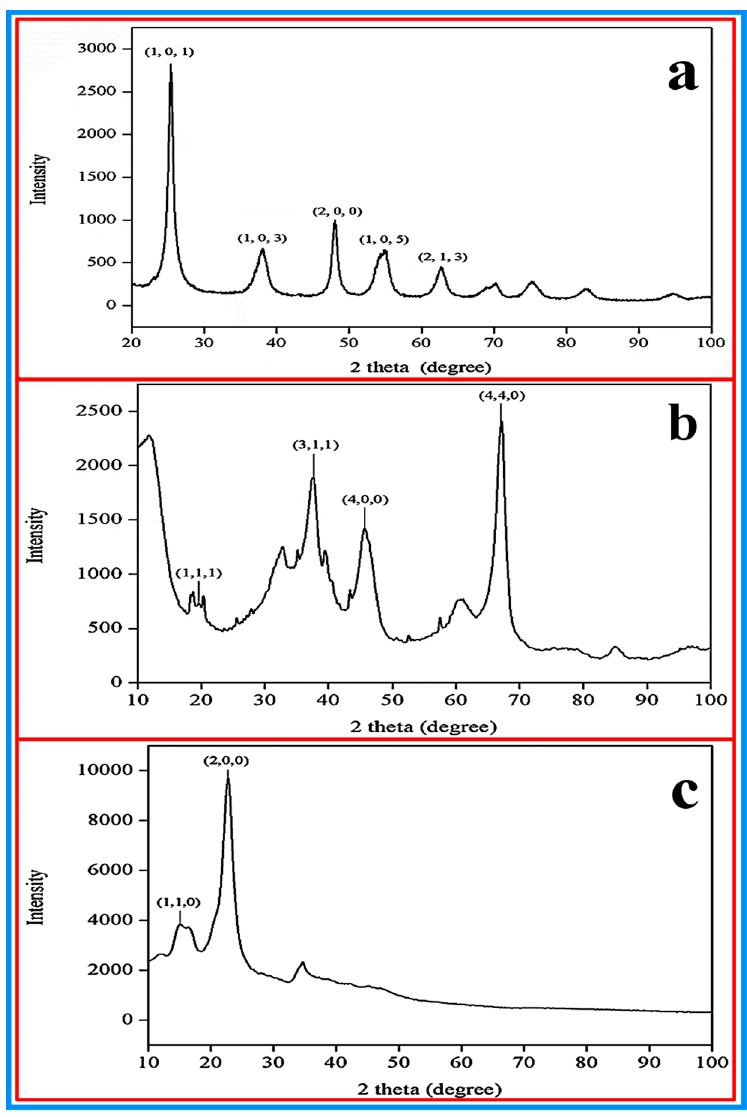
Figure 5. XRD patterns of ( a ) TiO 2 and ( b ) Al 2 O 3 nanoparticles, and ( c ) CNC.